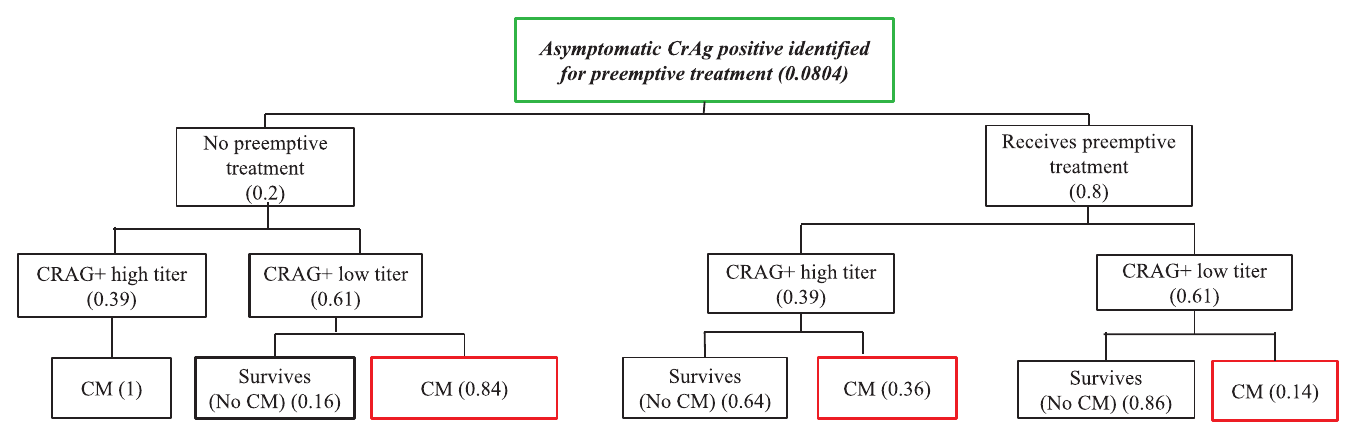
Fig 2. Base case model of treatment of Asymptomatic CrAg positive persons.